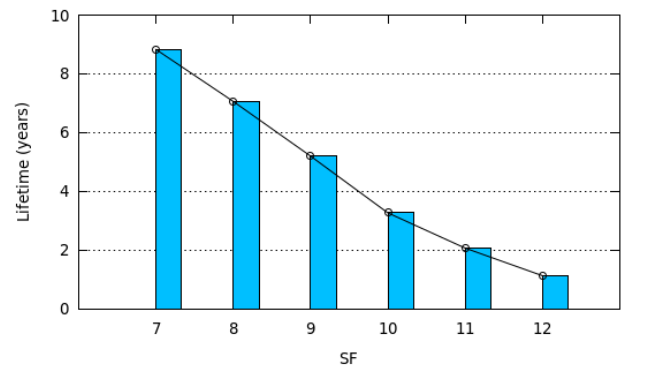
Figure 14. Network lifetime vs Spreading